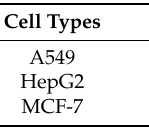
Table 2. The evaluation of explained variation ( R 2 X ) and predictive ability ( Q 2 (cum) ).